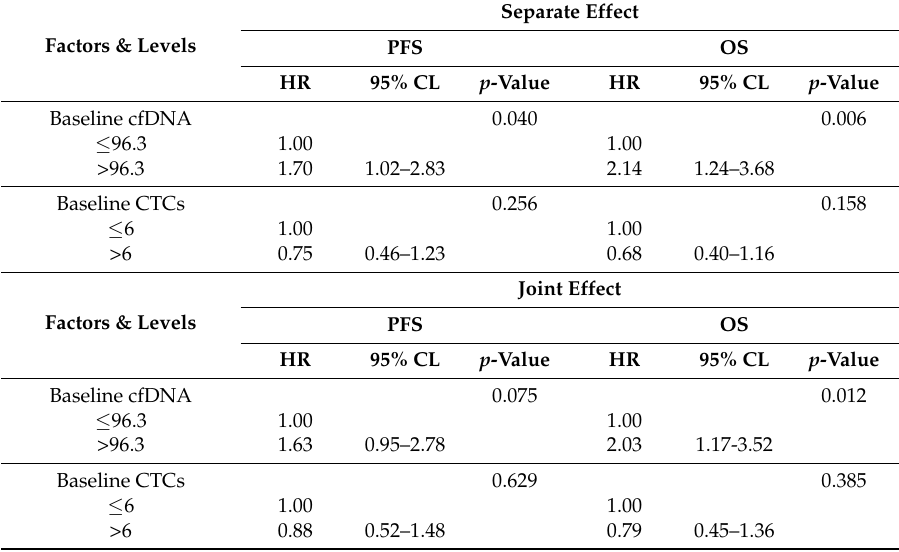
Table 3. Separate and joint effects of Cell-free DNA (cfDNA) and circulating tumor cells (CTCs) on progression free and overall survival probabilities estimated using the Cox multiple regression modeling.